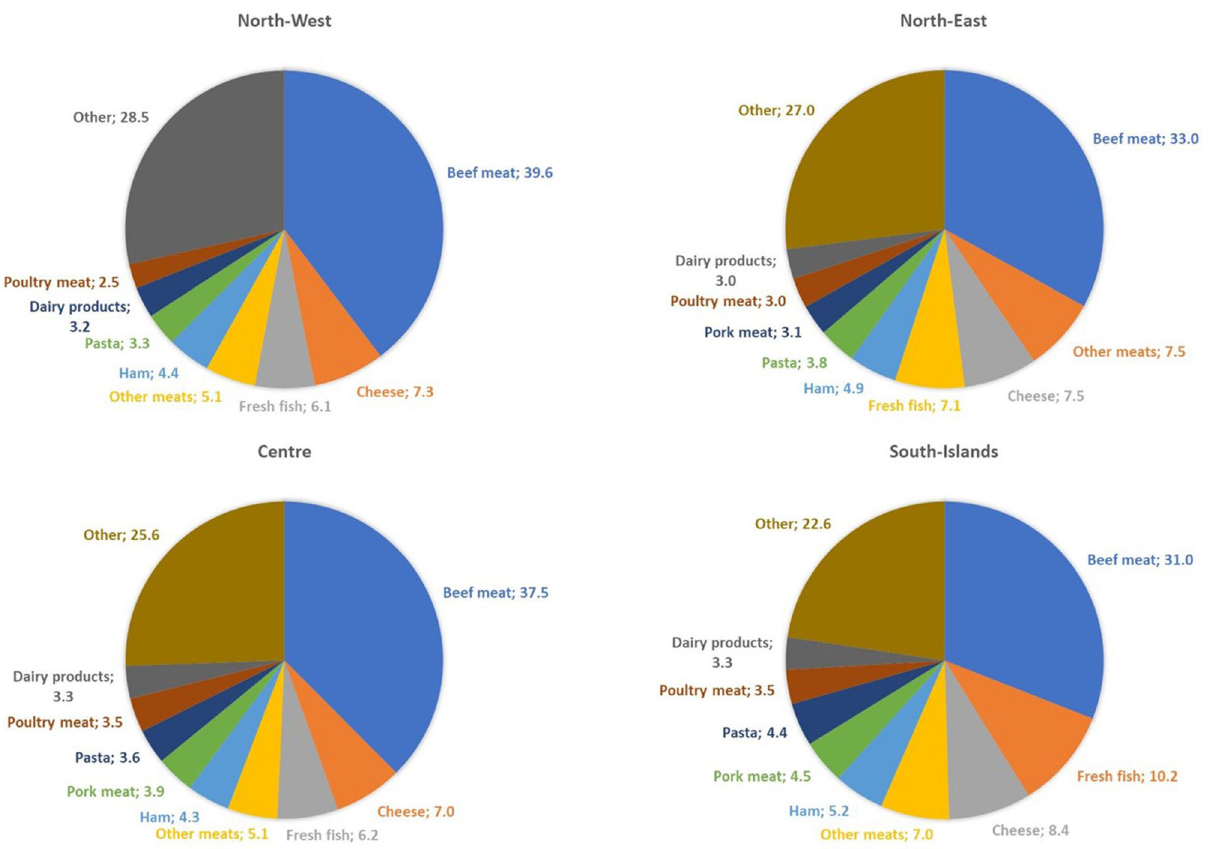
Figure 4. Contribution of food categories to the GHG emissions of Italian macro-regions. The Figure represents the percentage contribution of each food category to the total GHG emissions of the food consumed in excess, in each macro-region of